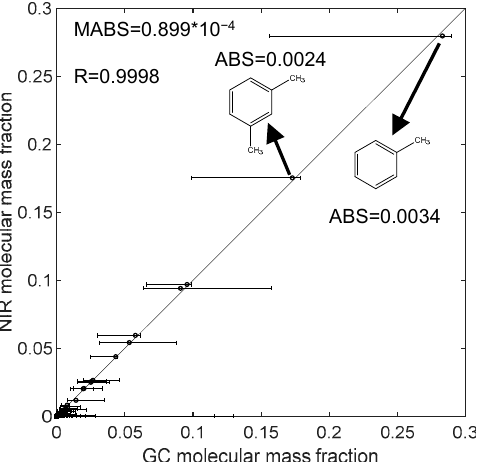
Figure 4. ( a ) NIR spectra of test samples and the selected base samples. Blue and red lines represent the NIR spectra of base samples and test sample, respectively. ( b ) The mixing ratio calculated by multiple linear regression. ( c ) Comparison of fitted NIR and measured NIR spectrum of test sample.